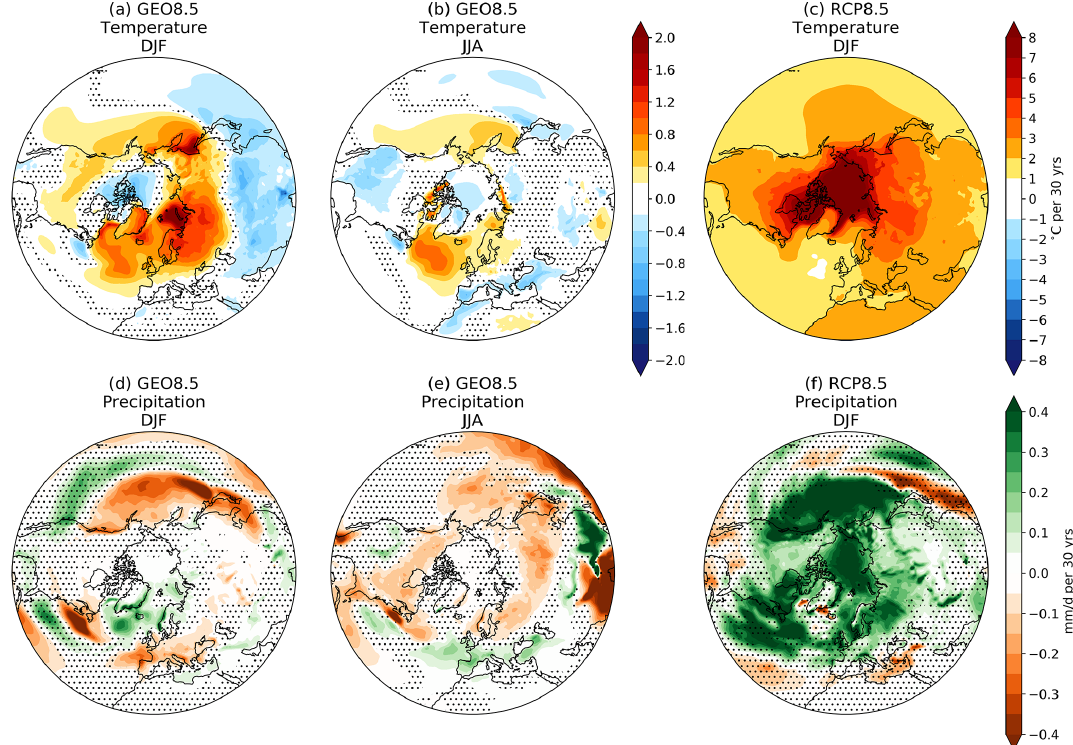
Figure 1. Trends in near-surface air temperature and precipitation. Ensemble mean linear trends in (a, b, c) temperature (in degrees Celsius per 30 years) and (d, e, f) precipitation (millimeters per day per 30 years) in different seasons and experiments. (a, d) GEO8.5 for DJF (December, January and February), (b, e) GEO8.5 for JJA (June, July and August) and (c, f) RCP8.5 for DJF. Stippling indicates a lack of statistical significance at the 95% confidence level under a one sample, two-sided Student’s t test using the standard deviation across ensemble